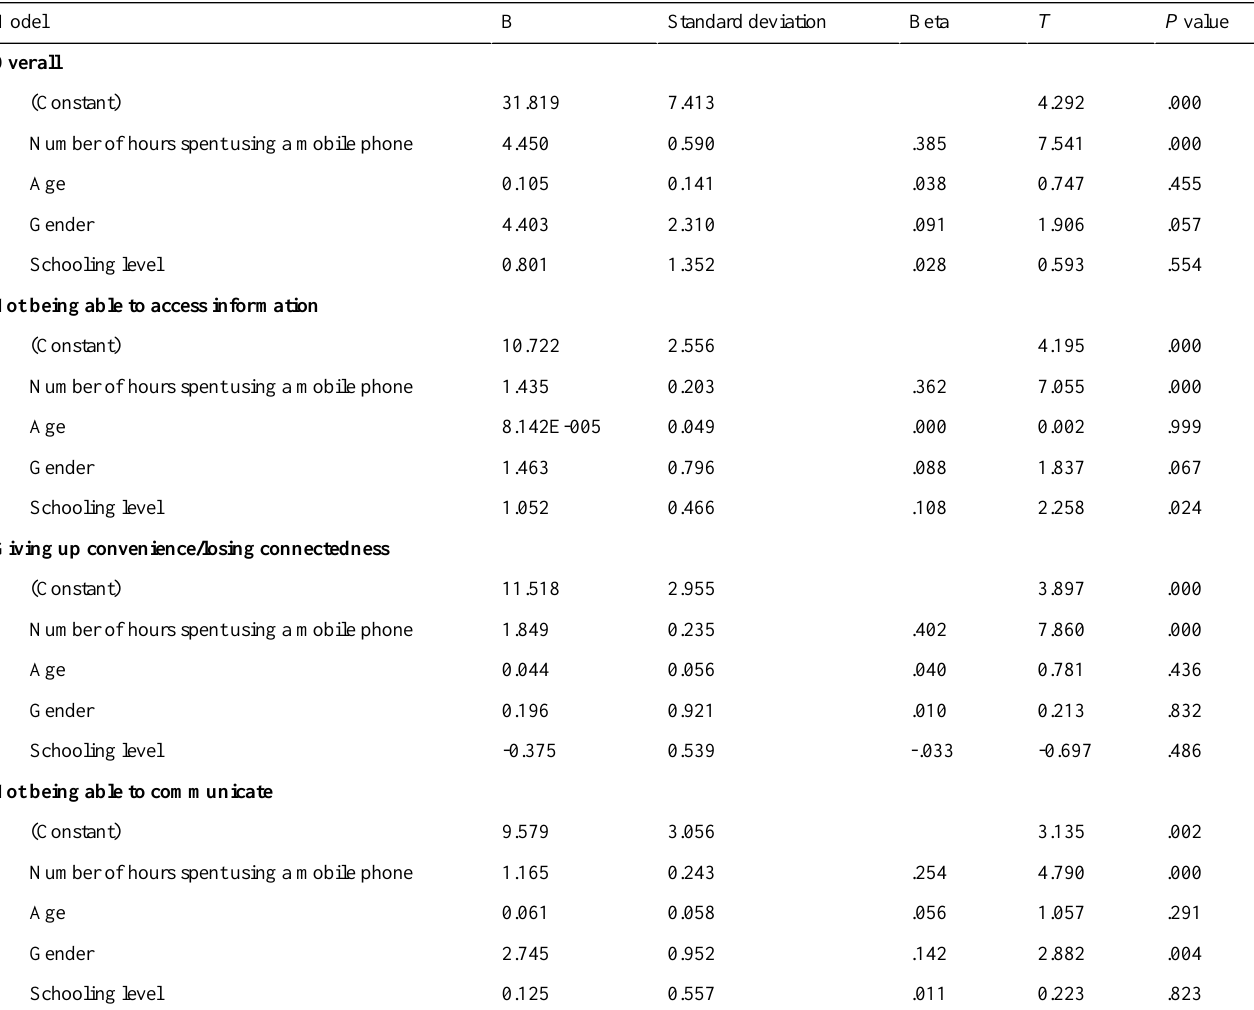
Table 4. Multivariate regression analysis investigating the impact of variables (age, gender, schooling level) on total and subscale scores.